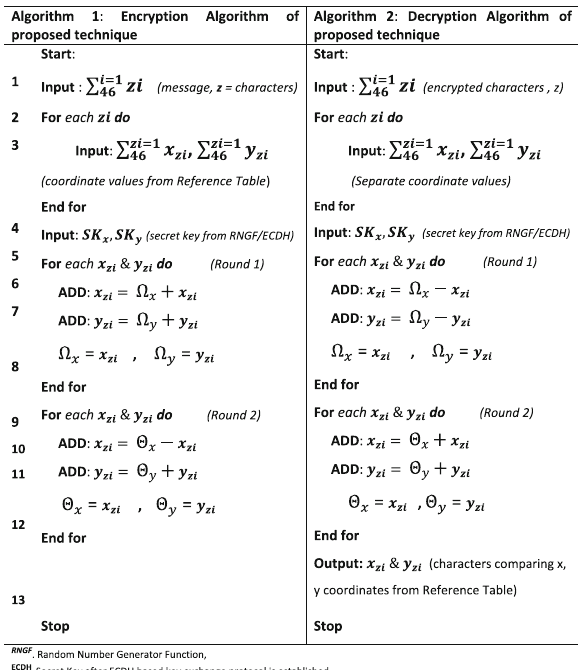
Table 2. Hash function of the proposed method